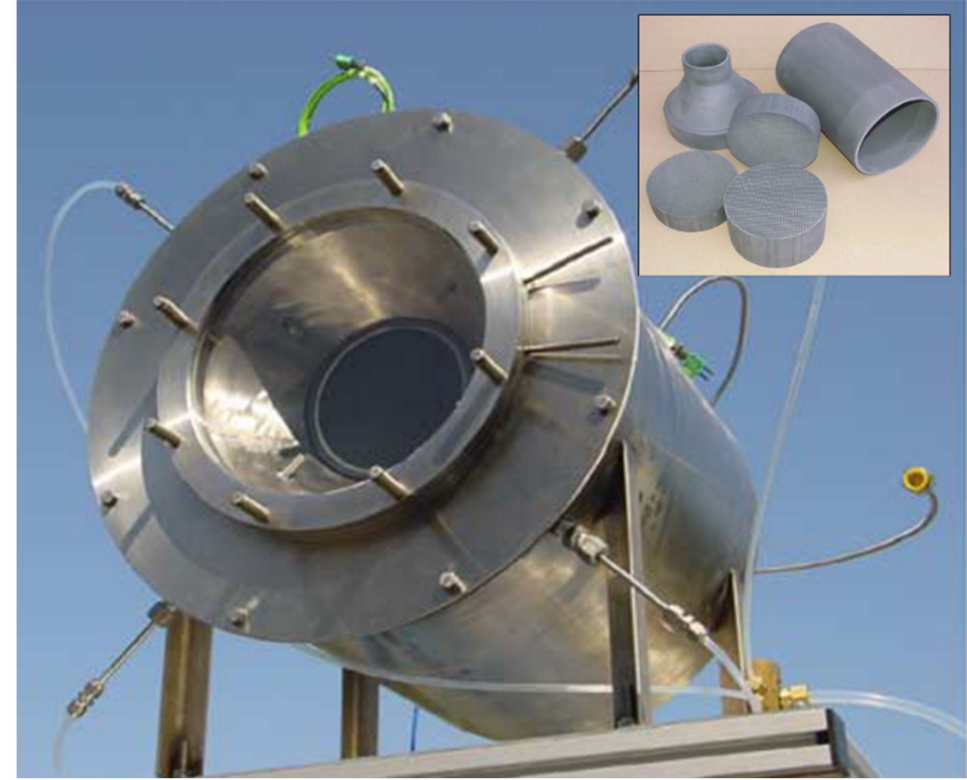
Figure 7. The HYDROSOL solar receiver-reactor used for water splitting showing the installment position and configuration of Mn/Zn-ferrite coated SiC honeycombs